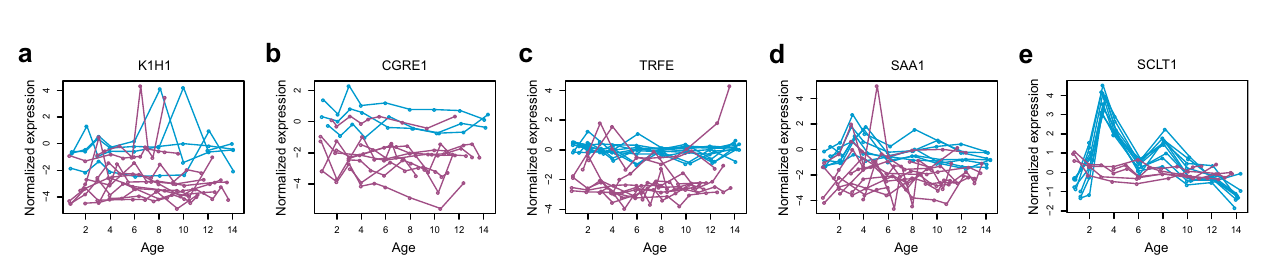
Fig. 5 | Longitudinal expression of representative examples of the top differ- ential expression detections by the Reproducibility optimized longitudinal Differential Expression method RolDE in the longitudinal type 1 diabetes blood plasma proteomics data of Liu et al. 10 . a Type I cuticular keratin (K1H1), b Cell growth regulator with EF hand domain protein 1 (CGRE1), c